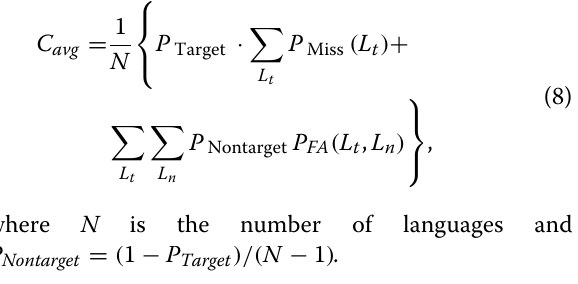
Table 3 Parameters of the conformer ASR model Conformer encoder Number of